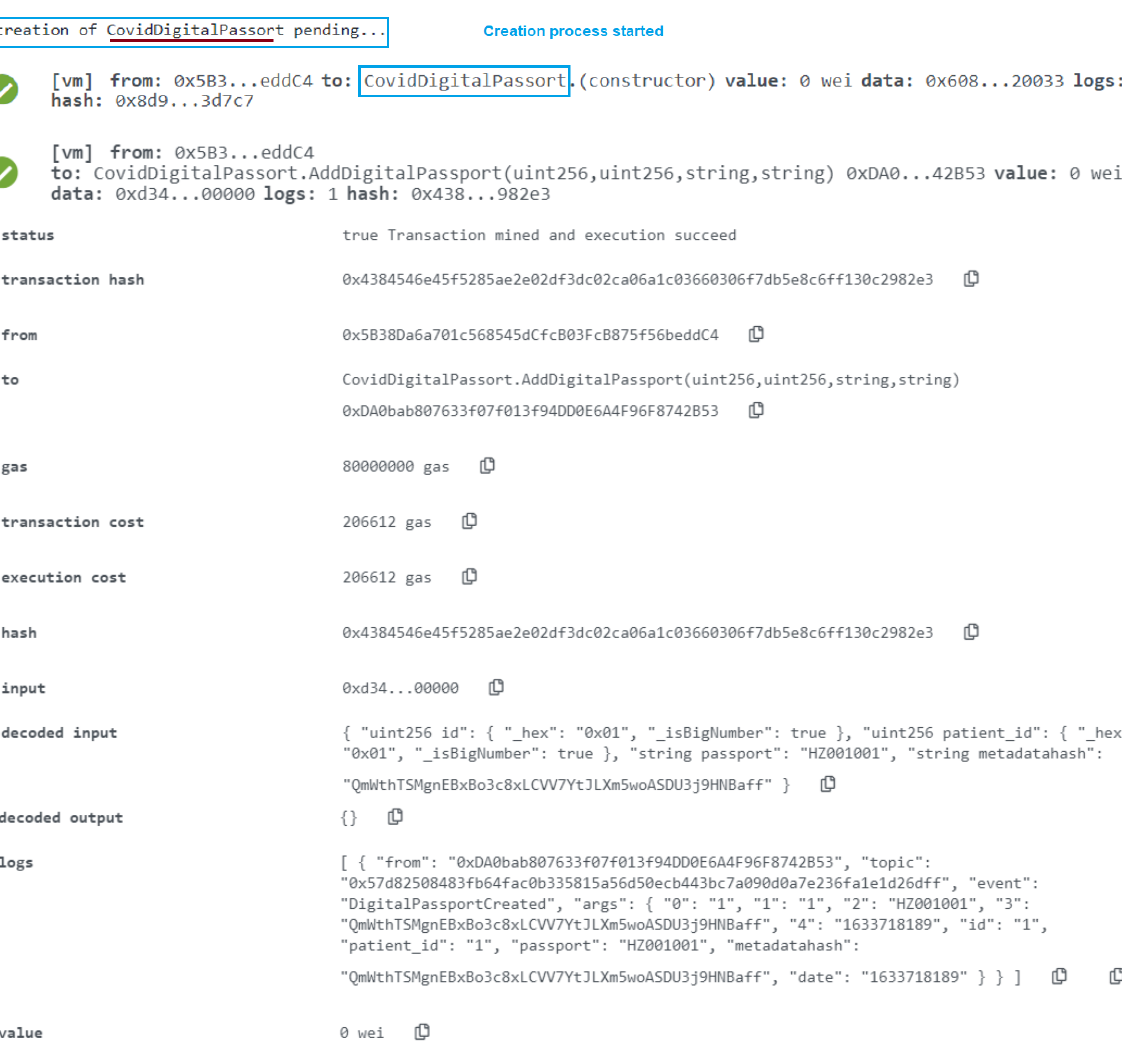
Figure 11. Upload COVID ‐ 19 DHP based on Testing/Vaccination and save detail in the blockchain ledger.\